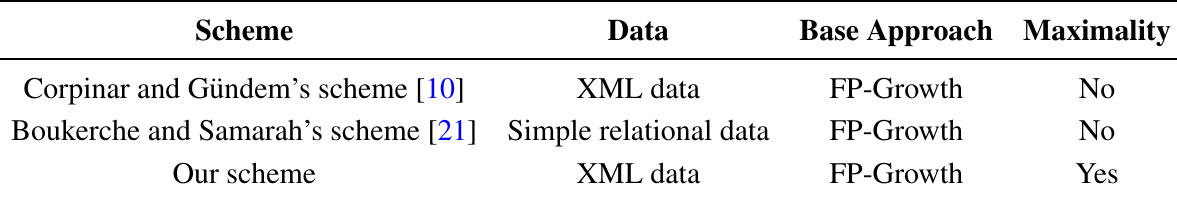
Table 1. A comparison of the